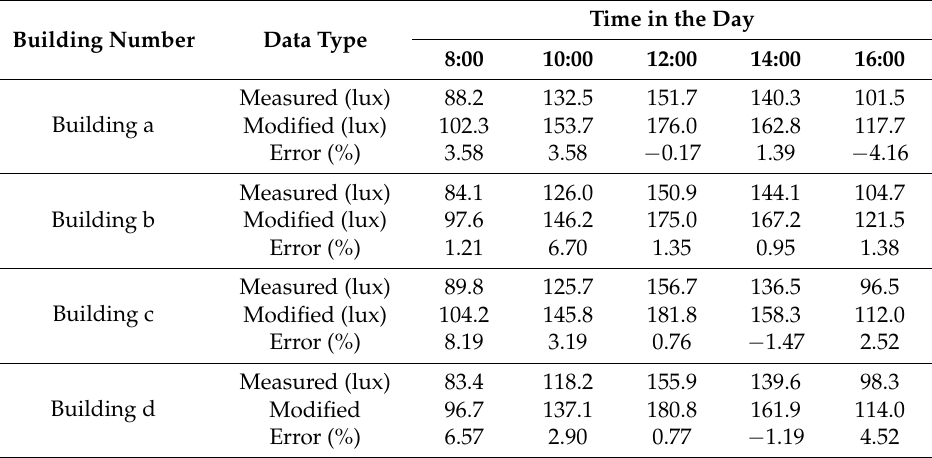
Table 6. The measured and modified illumination intensity of the SOGL system in the experimental study at different times in the day and their relative errors to the simulated results ( α = 1.16).